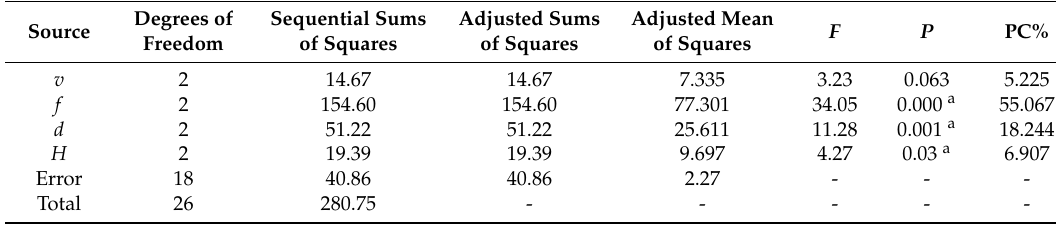
Table 11. Analysis of variance for surface roughness.